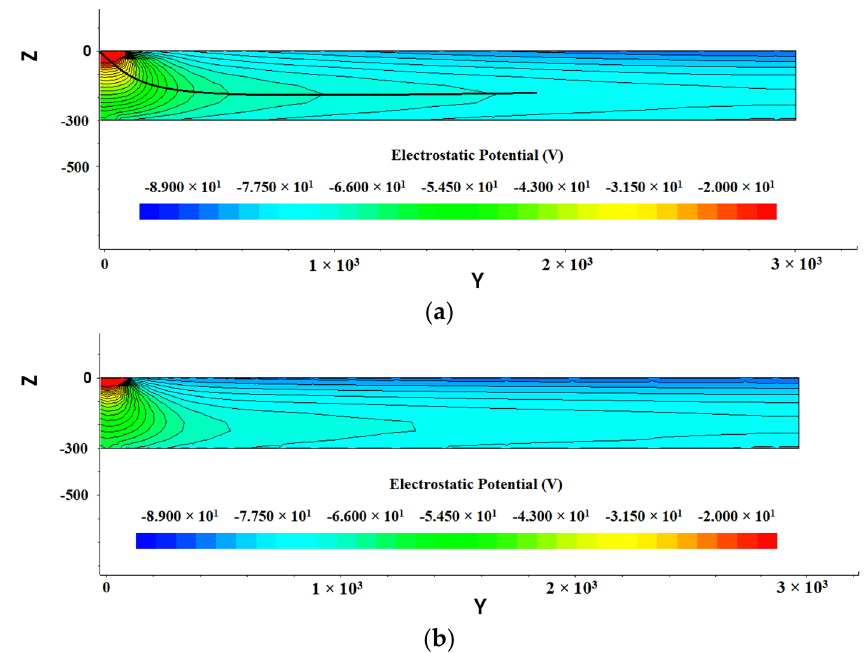
Figure 5. Internal potential distribution of SDD: ( a ) gap 10 µm; ( b ) gap 25 µm.